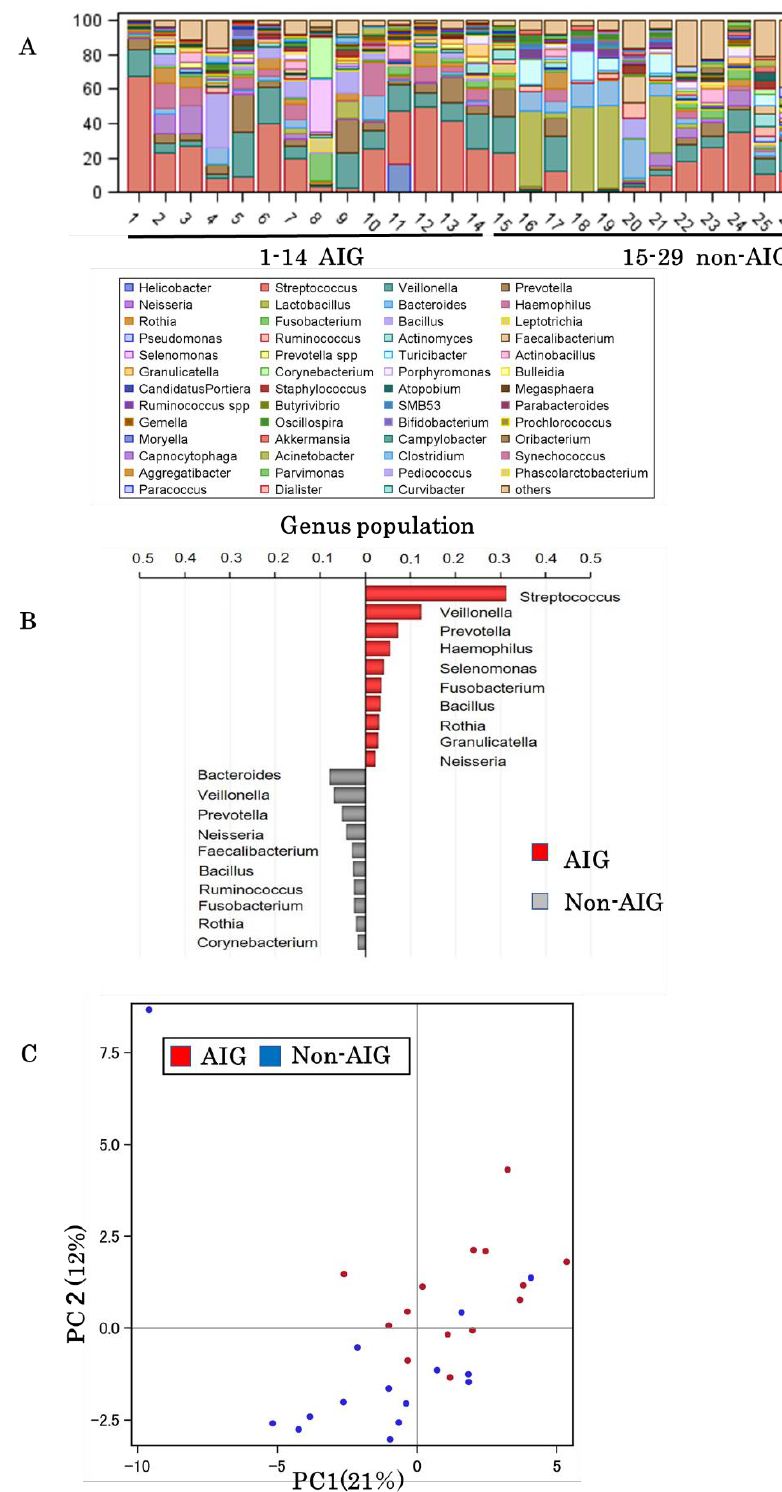
Figure 2. Gastric flora analysis. ( A ) Taxonomy, genus level. Comparison between AIG and non-AIG; ( B ) The ten most relevant genus taxa between AIG and non-AIG; ( C ) Principal coordinate analysis between AIG and non-AIG.